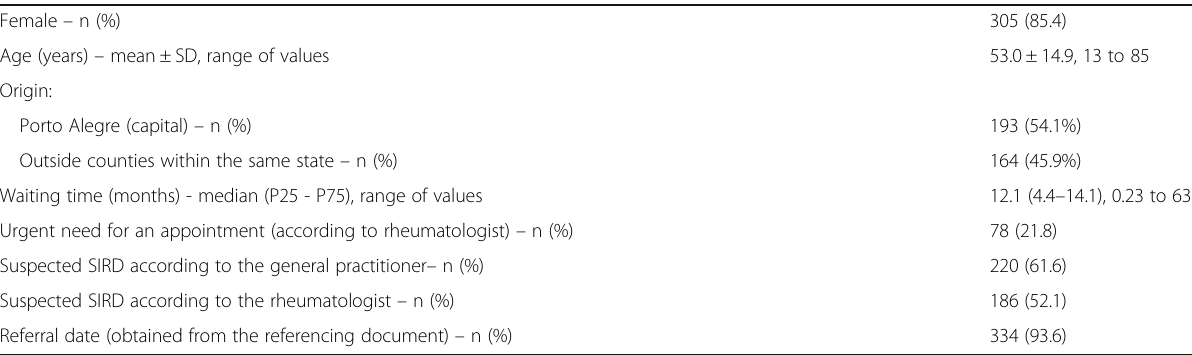
Table 1 Demographic characteristics of eligible patients (total of 357 patients) Female – n